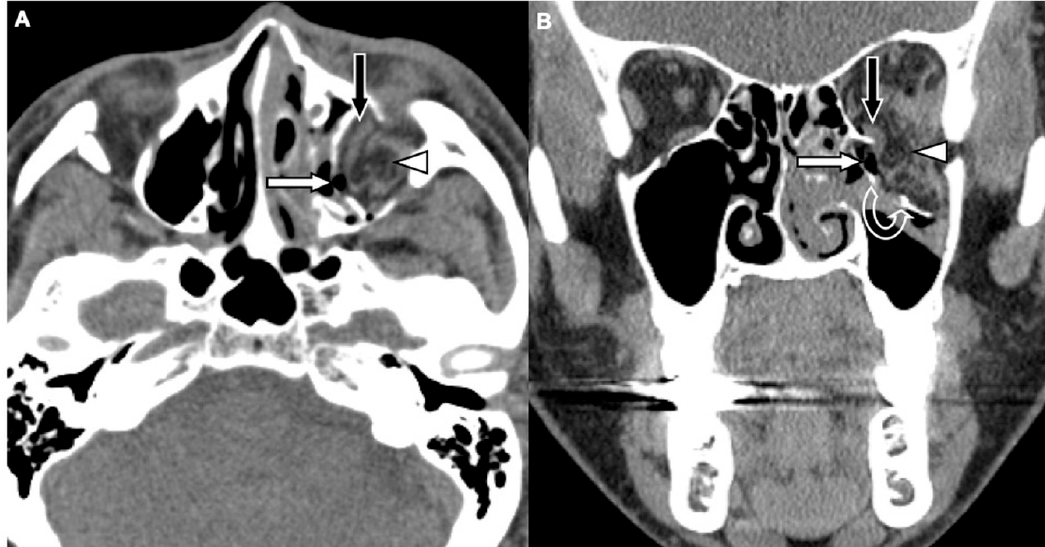
Figure 2. CT images of a 62-year-old female with motorcycle crash-related head trauma and a concomitant left OFF. An axial head CT image ( A ) and the corresponding coronal facial CT image ( B ) show inferior extraconal emphysema (straight white arrow) beneath the inferior rectus muscle (black arrow), orbital fat herniation into the maxillary sinus (arrowhead), and the depressed fragments of fractured orbital floor (open curved arrow).